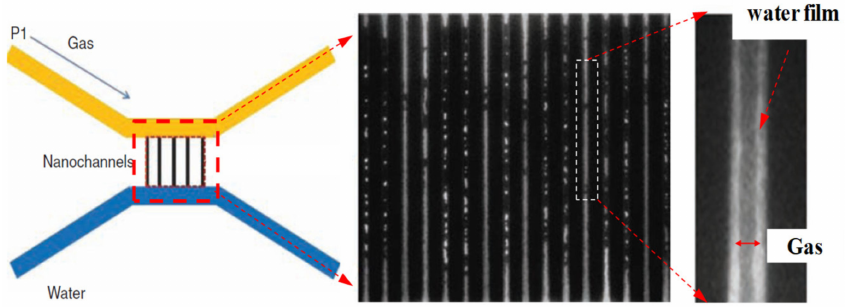
Figure 15. Experiments of gas/water flow inside nanochannels.